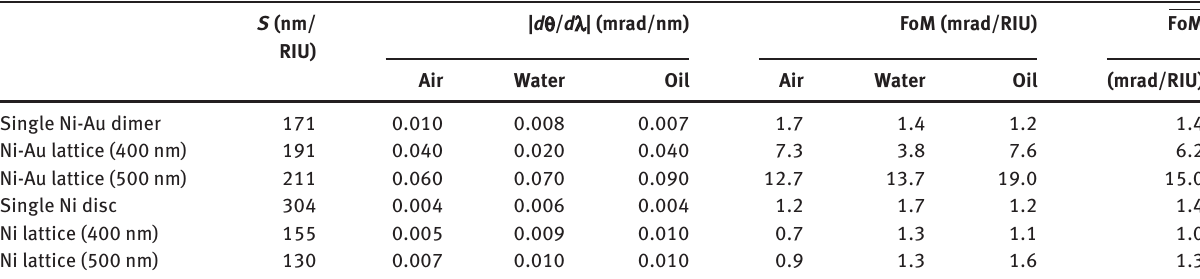
Table 1: Sensitivity ( S ), absolute value of d θ / d λ , and FoM extracted from Faraday rotation measurements on all samples in air, water, and index matching